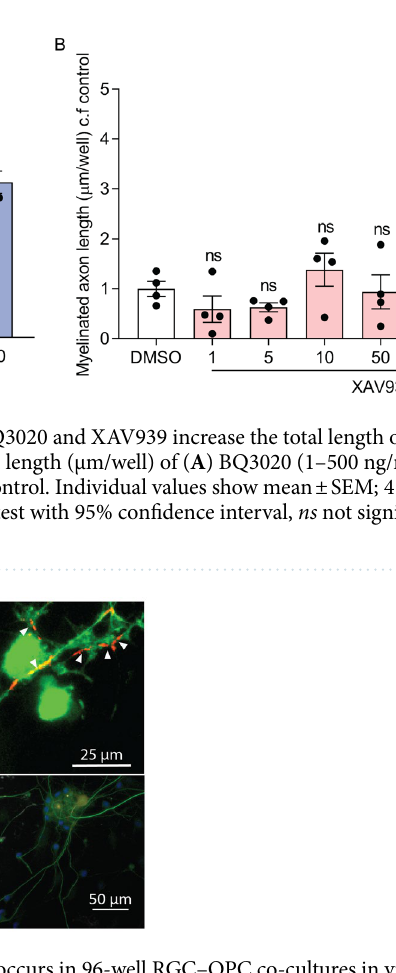
Figure 5. Compact myelin formation occurs in 96-well RGC–OPC co-cultures in vitro . RGC–OPC co-culture in a 96-well plate format stained for MBP (grey), Smi31 (green), Caspr (red), and DAPI (blue). White arrows indicate paranodal Caspr staining (red) overlapping with Smi31 (green) and therapy flanking the